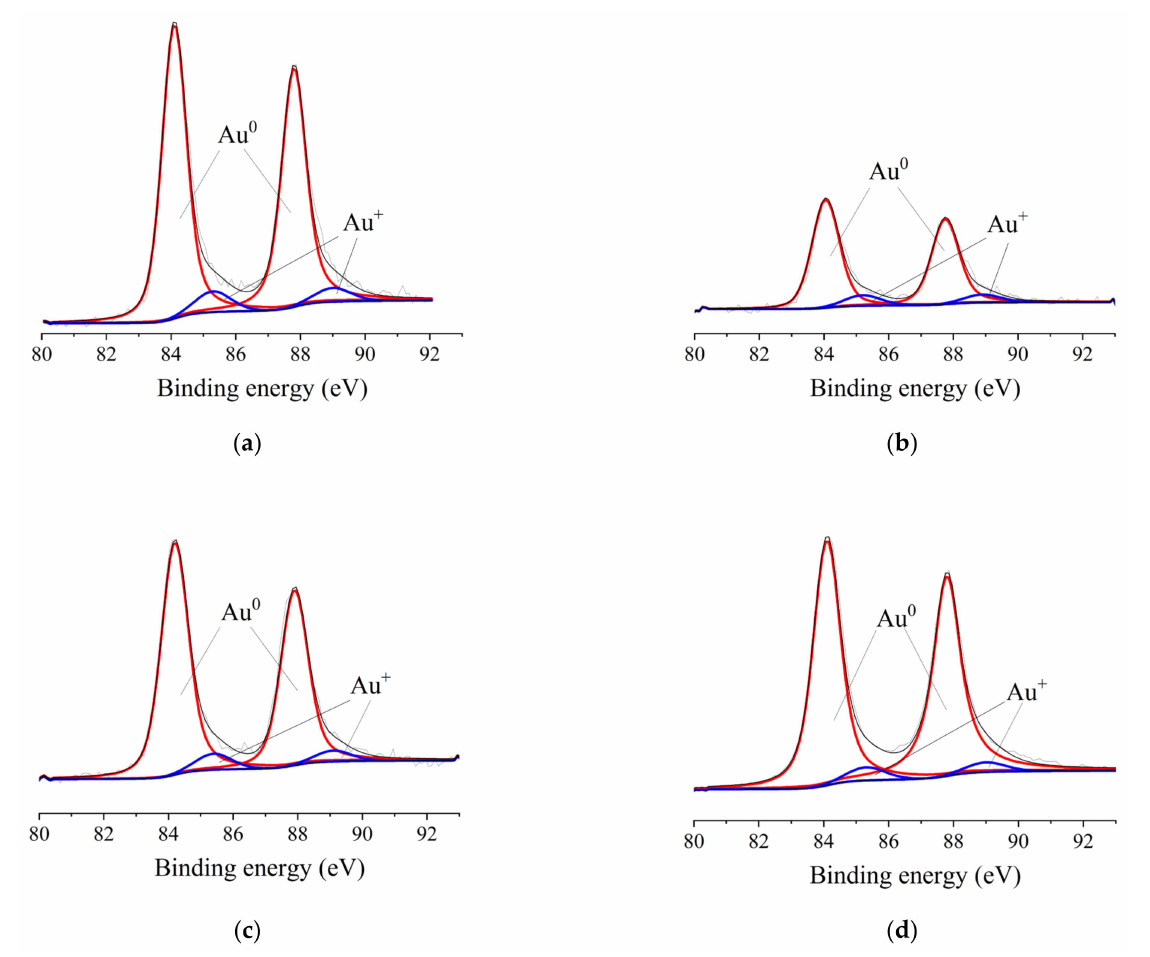
Figure 7. Au4f XPS spectra of ( a ) Pd-Au/Cp, ( b ) Pd-Au/Cp-COOH, ( c ) Pd-Au/Cp-butyl and ( d ) Pd-Au/Cp-NH 2